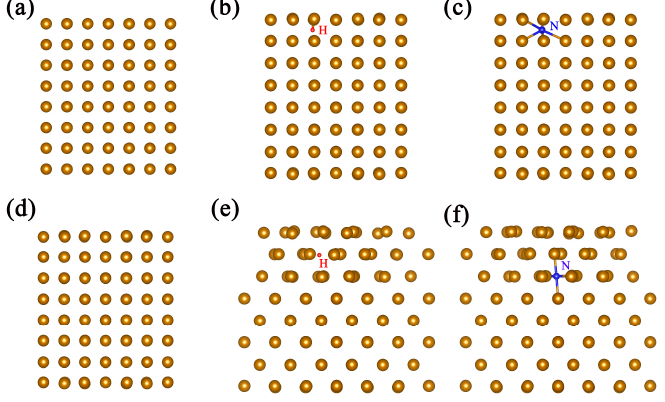
Figure 1. Models of pure γ -Fe and H/N-containing austenite. ( a – c ) are the models of pure γ -Fe and H/N-containing austenite before geometry optimization, respectively. ( d – f ) are the models of pure γ -Fe and H/N-containing austenite after geometry optimization, respectively.